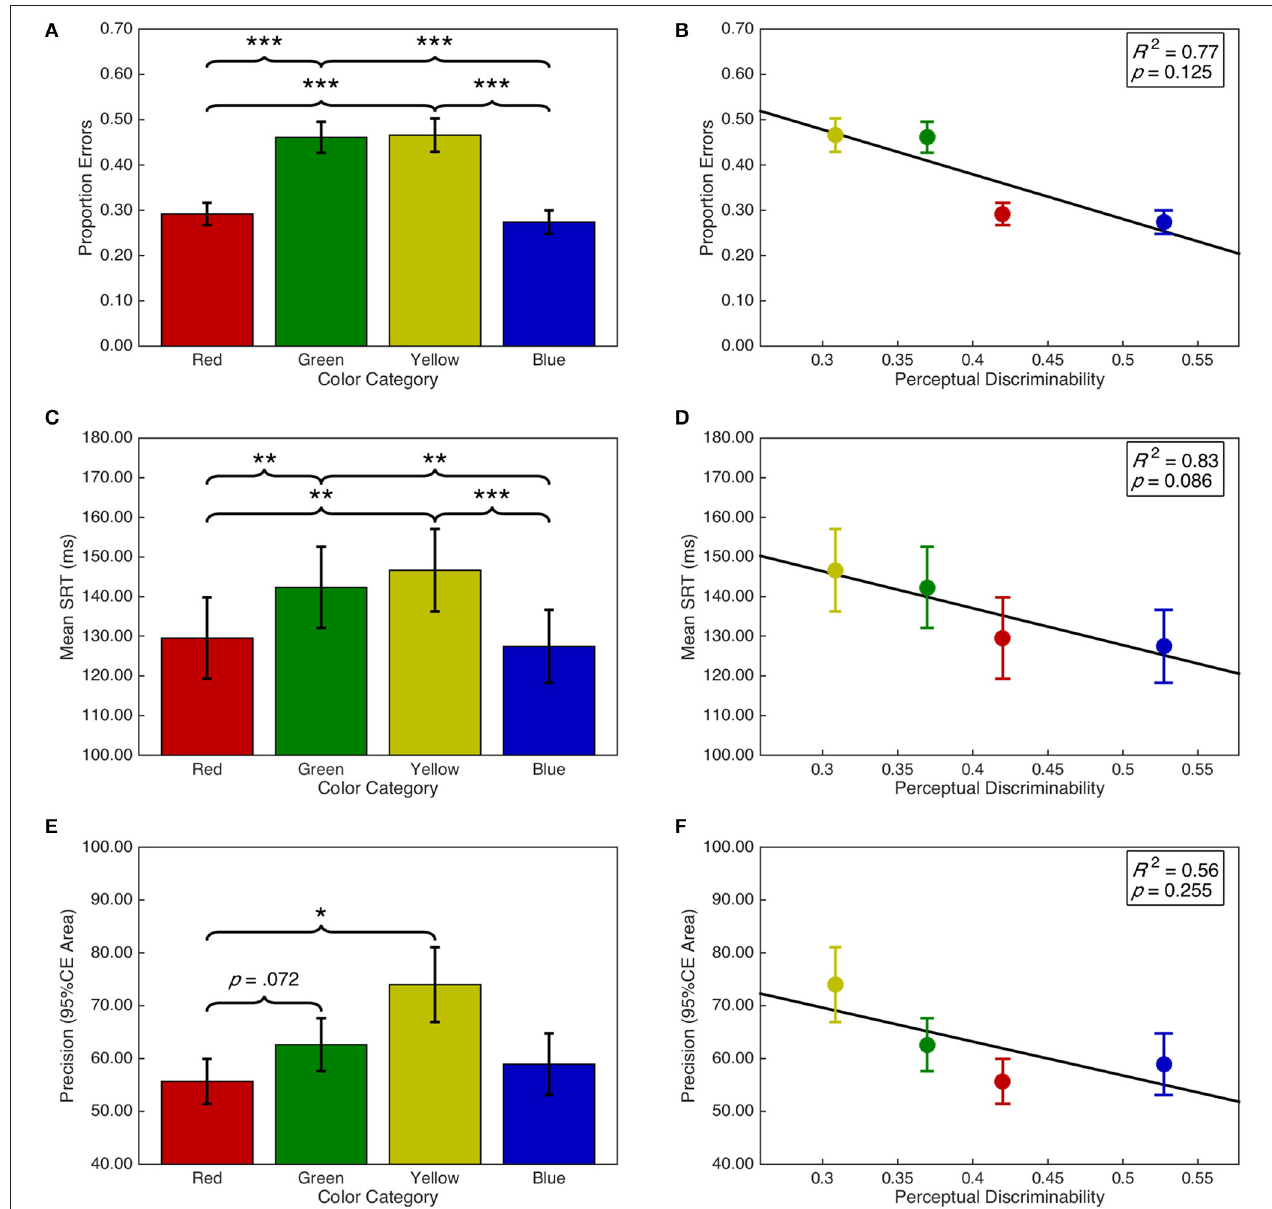
FIGURE 7 | Task performance as a function of target color category and discriminability. Error bars represent standard error. Right panels include line of best fit, the coefficient of determination, and significance level from the regression analyses. (A) Proportion of errors per target color category. (B) Proportion of errors as a